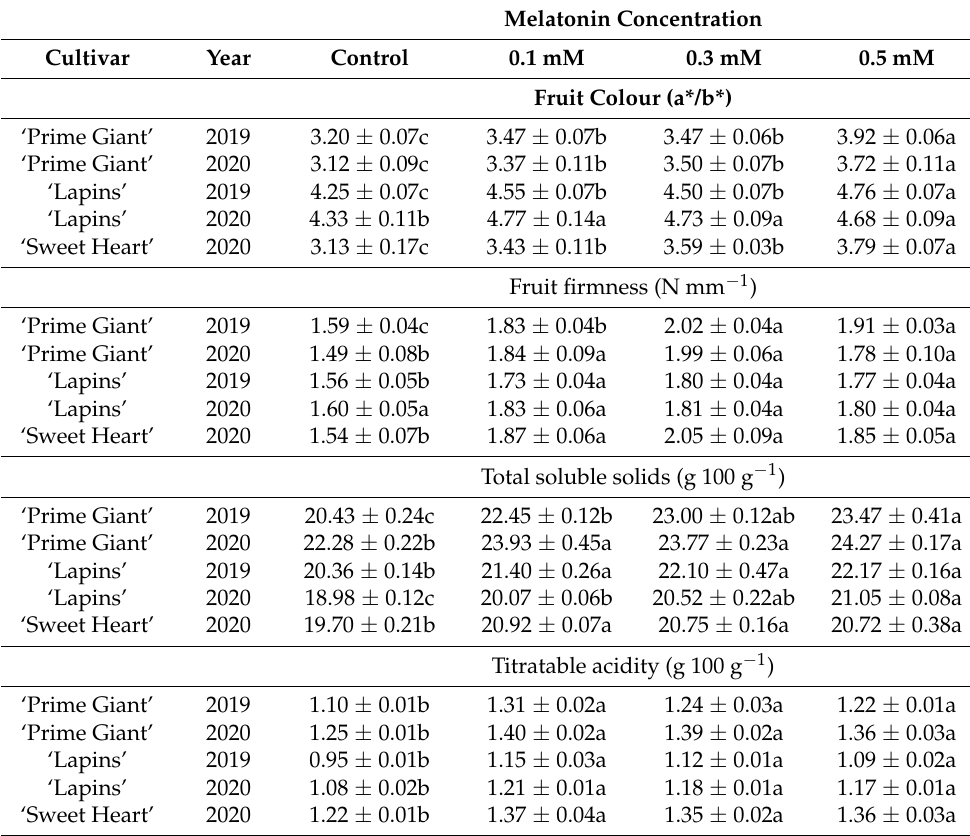
Data are the mean ± SE of fruits harvested from three replicates of three trees for the 2019 and 2020 experiments. For each cultivar and year, different lowercase letters show significant differences ( p < 0.05) between